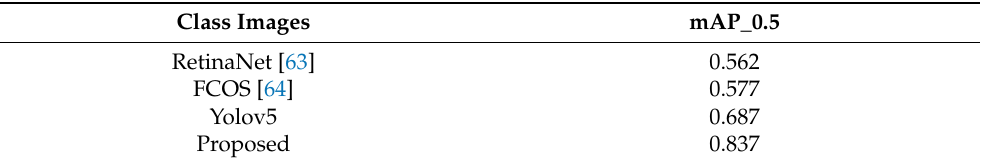
Table 7. Comparison with the latest target detection